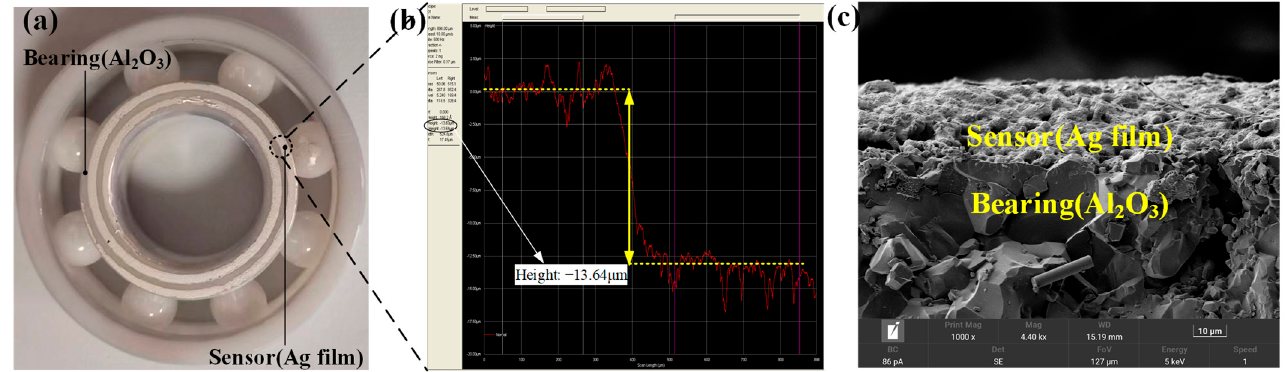
Figure 2. ( a ) Physical bearing after preparation; ( b ) measured thickness of the Ag film using a step meter; ( c ) SEM diagram of the Ag film and bearing cross section.